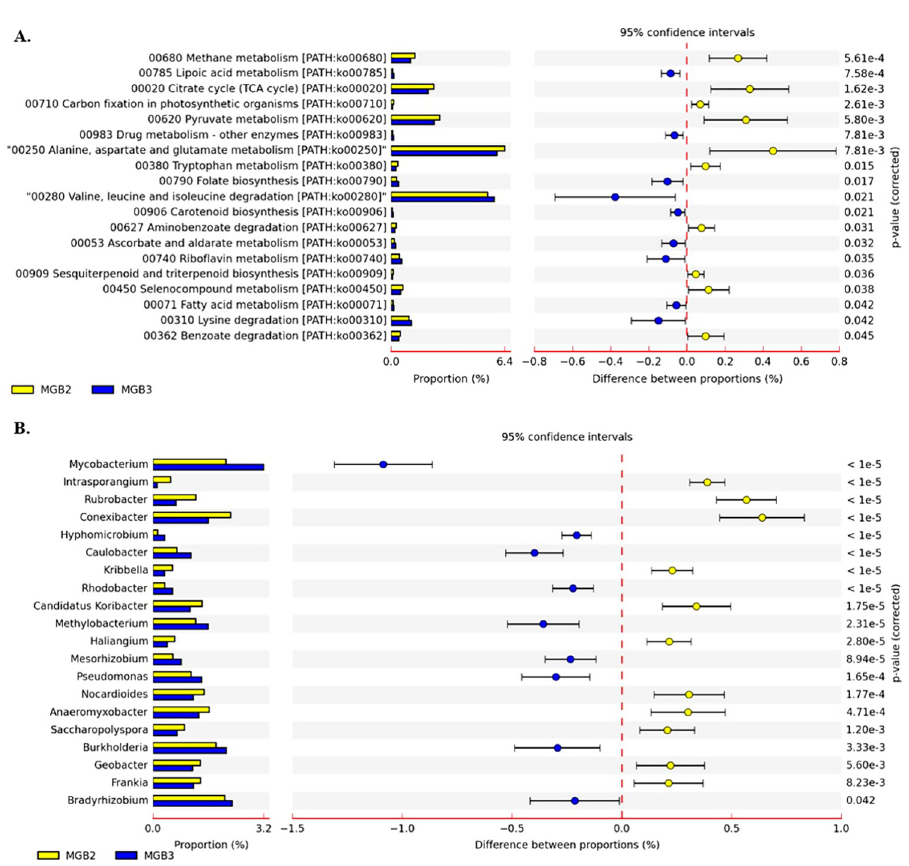
Fig 3. Comparative analysis of metagenome MGB-2 and MGB-3 using STAMP. (A) SEED level based on metabolism (B) genus level with RefSeq for metabolism.